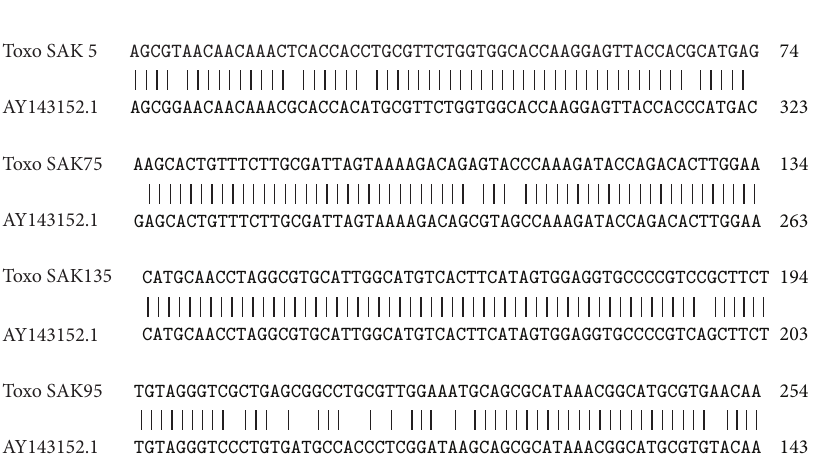
Figure 2: Alignment of sequence of Toxoplasma isolated from amniotic fluid of the patient. Toxo SAK: sample from the patient; AY143152.1: sequence ID of Toxoplasma gondii strain type I uracil phosphoribosyltransferase (UPRT)